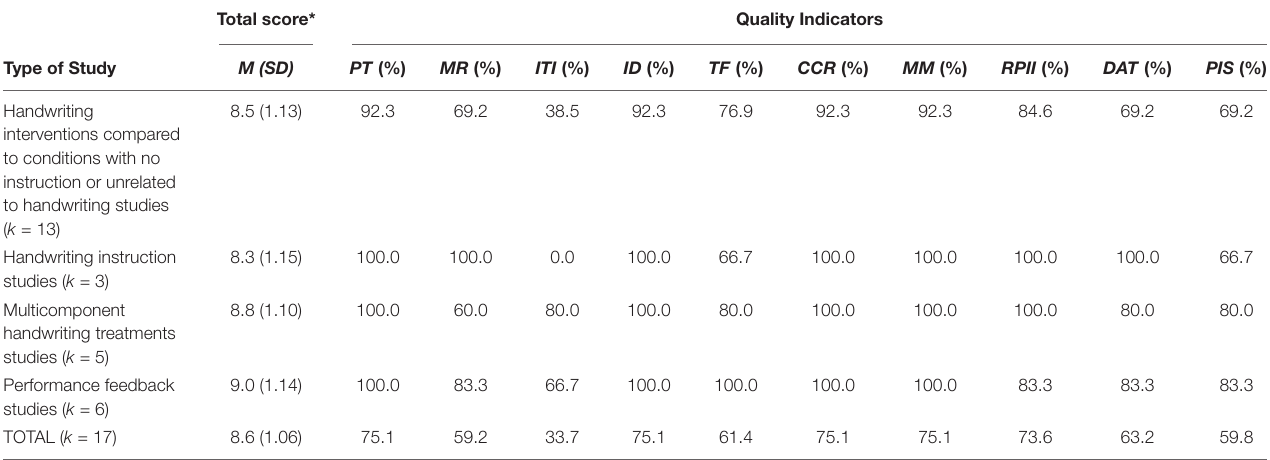
TABLE 3 | Total quality score and percentage of studies in which a quality indicator by types of